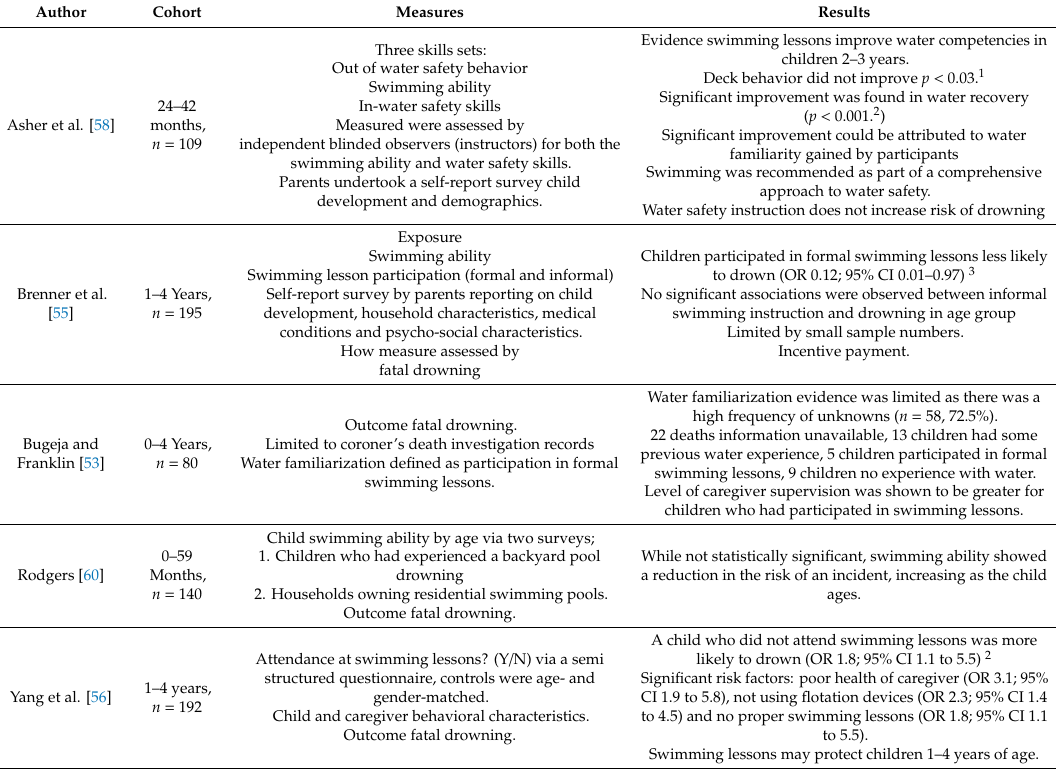
Table 3. Water competencies as an intervention for reducing drowning